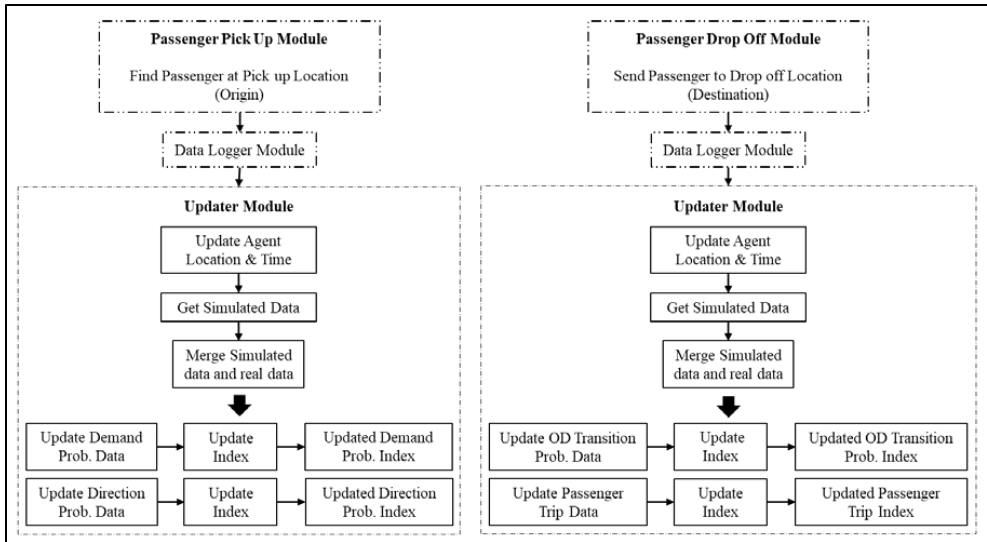
Figure 16. Data logger and updater module.